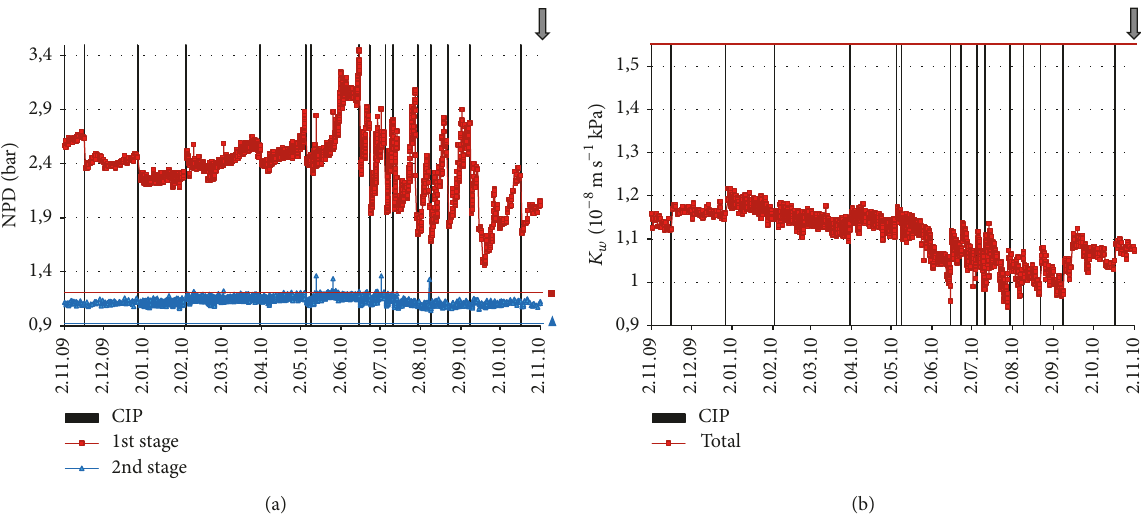
Figure 2: Key performance parameters NPD (a) and 𝐾 𝑤 (b) of plant location II. Vertical lines indicate CIP. Horizontal lines indicate performance with new membranes [day zero]. From this installation, a lead element from the first stage was taken (02.11.2010). Time point of membrane autopsy is indicated with dark grey arrow.